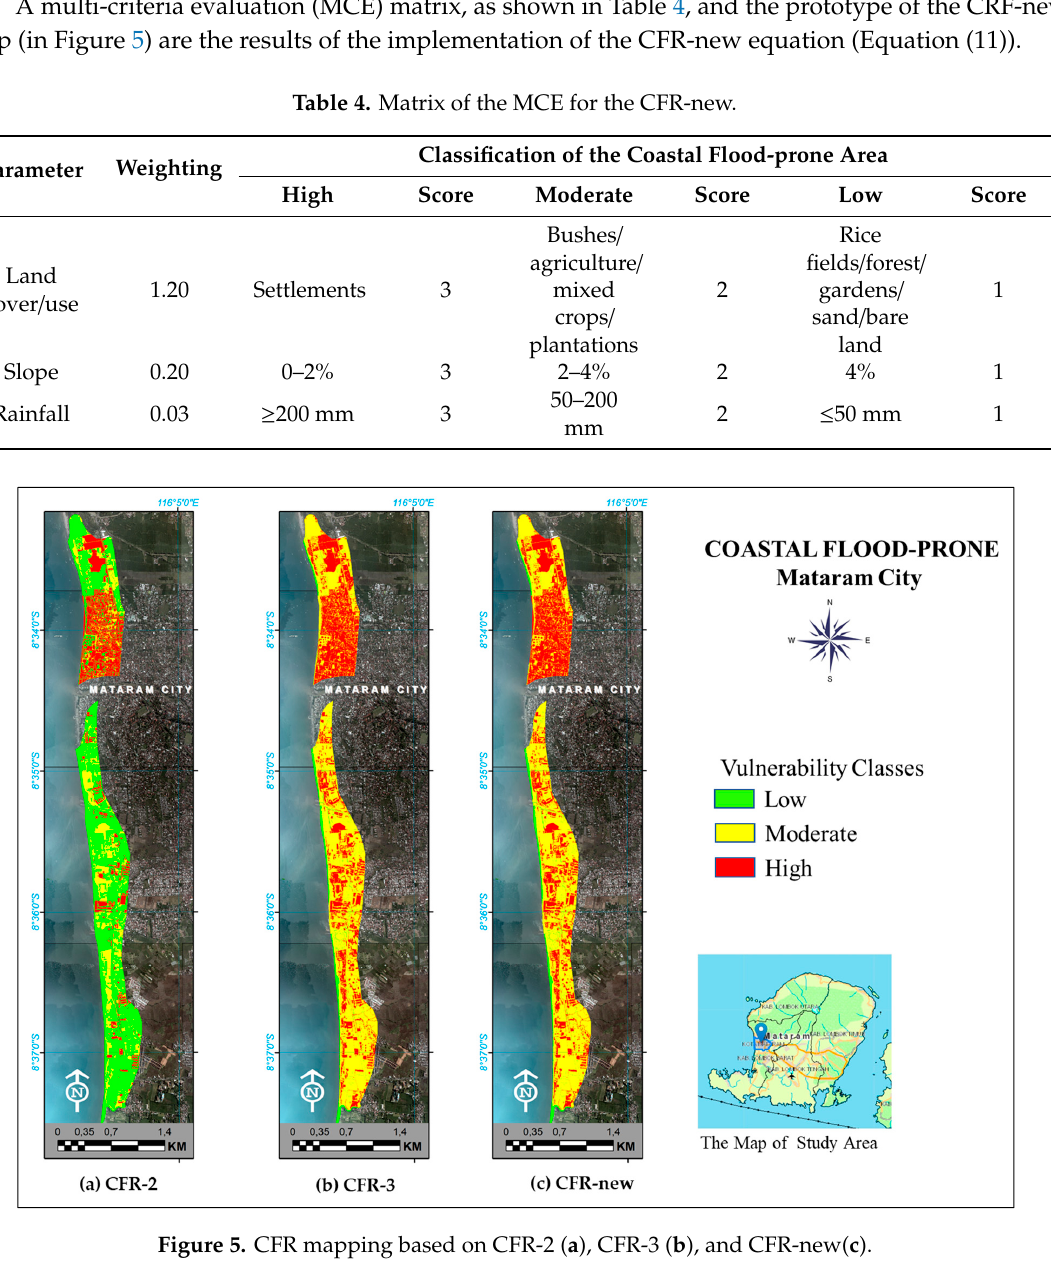
Figure 5. CFR mapping based on CFR-2 ( a ), CFR-3 ( b ), and CFR-new( c ).